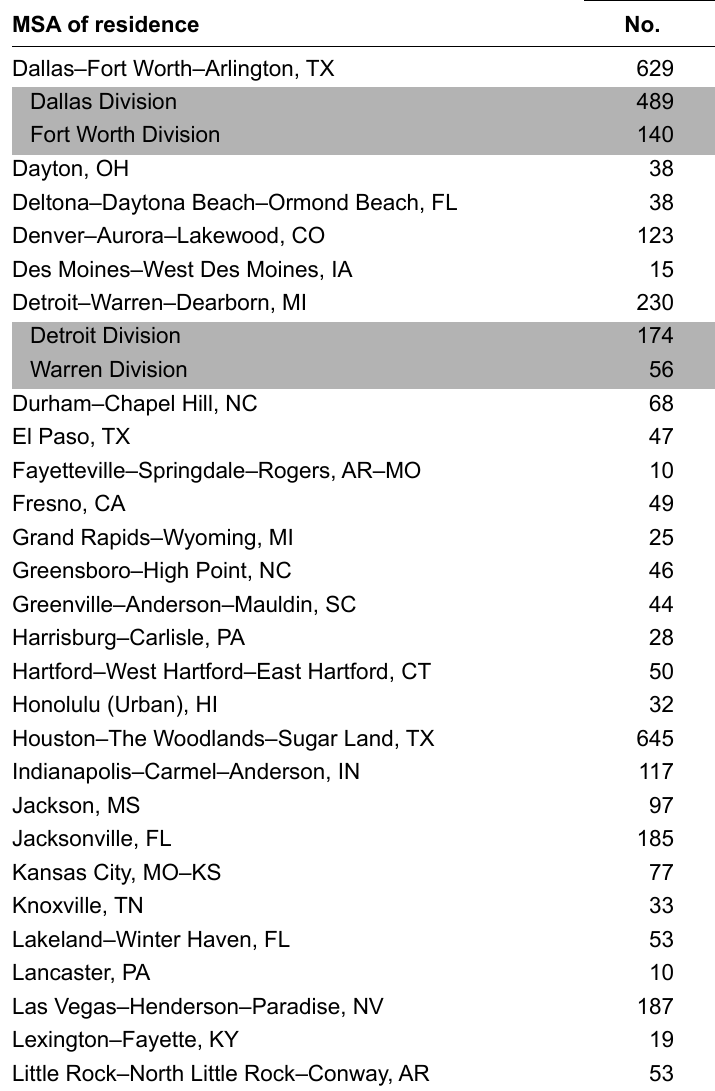
Table 27. Stage 3 (AIDS), 2015 and cumulative, and persons living with diagnosed HIV infection ever classified as stage 3 (AIDS) (prevalence), year-end 2014, by metropolitan statistical area of residence—United States and Puerto Rico (cont) Diagnosis, cumulative a Prevalence of stage Diagnosis, 2015 b